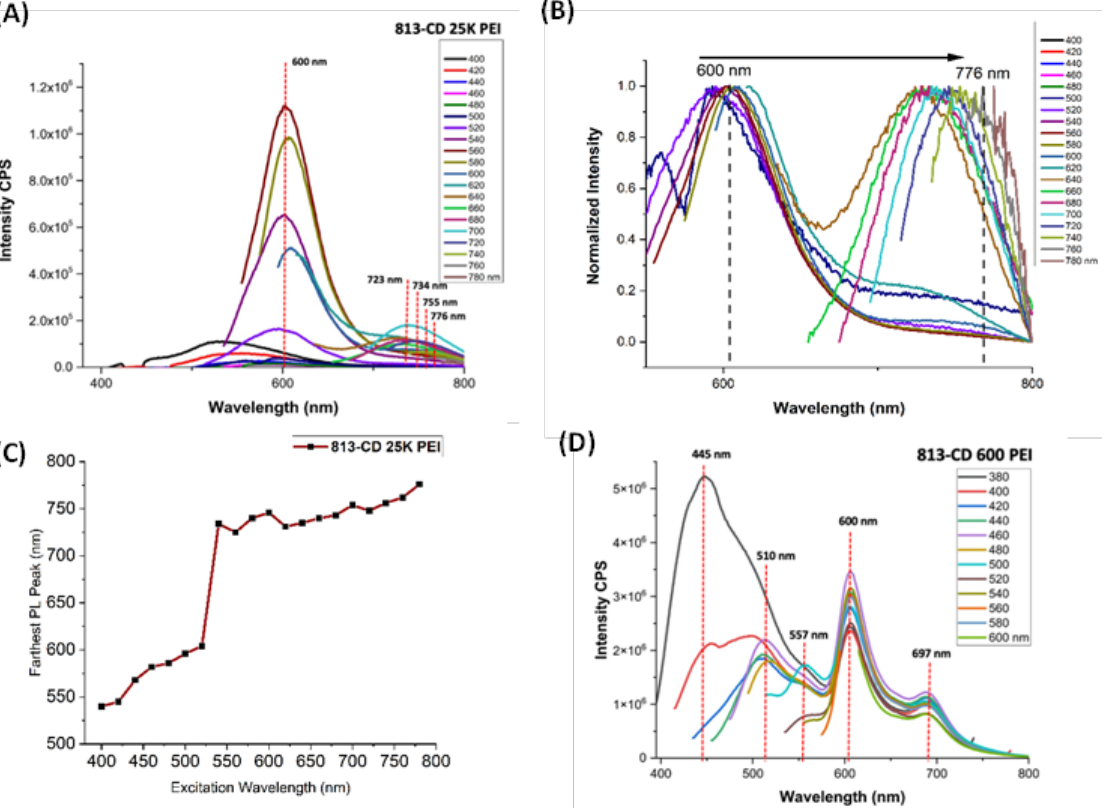
Figure 4. PL spectra of 813-CDs. ( A ) PL spectrum of 813-CD 25k PEI. ( B ) Normalized PL spectrum of 813-CD 25k PEI. ( C ) Plot of the second PL peak for 813-CD-25K PEI vs. excitation wavelength (nm). ( D ) PL spectrum of 813-CD 600 PEI.